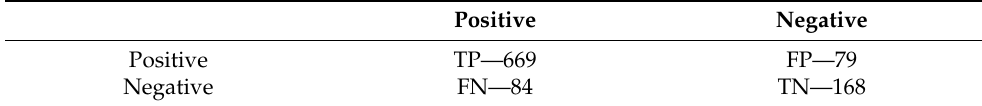
Table 6. Confusion Matrix of Base Paper.